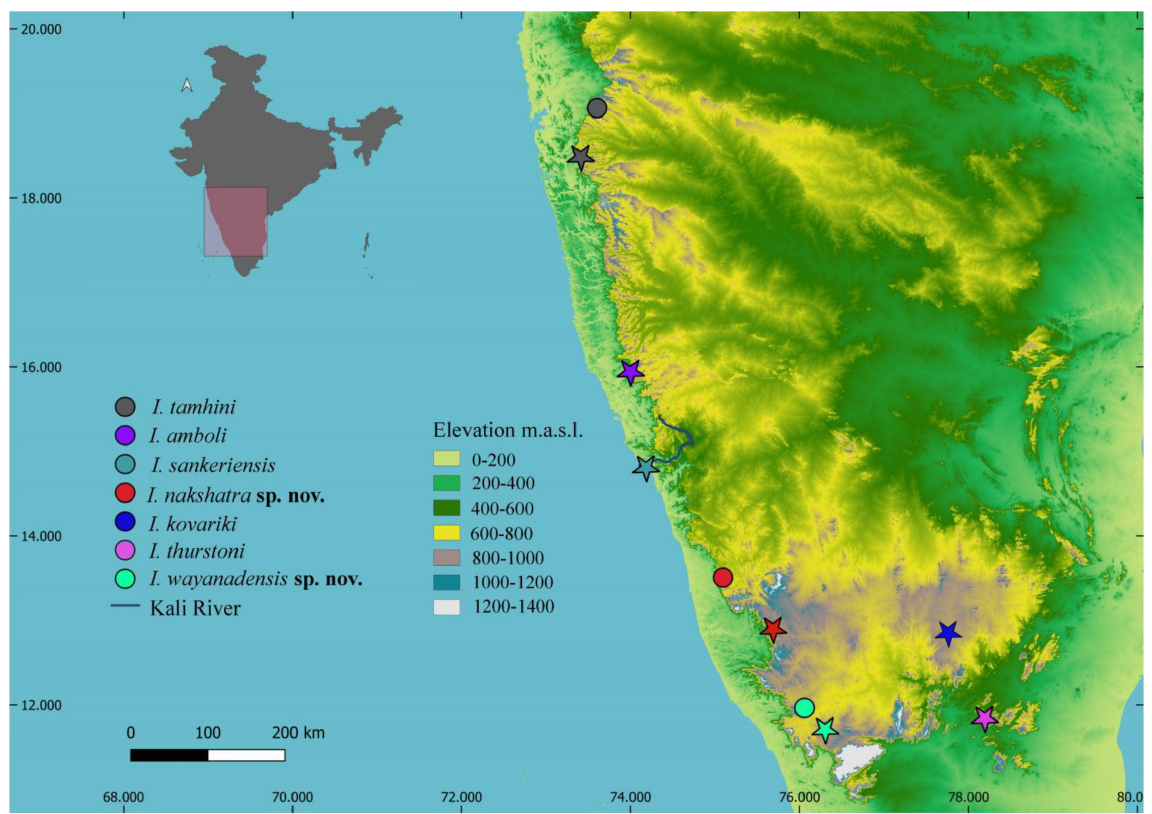
Fig. 26. Distribution of Indian species of Isometrus Ehrenberg, 1828 with elevation data. Stars represent type localities and circles represent additional sampled